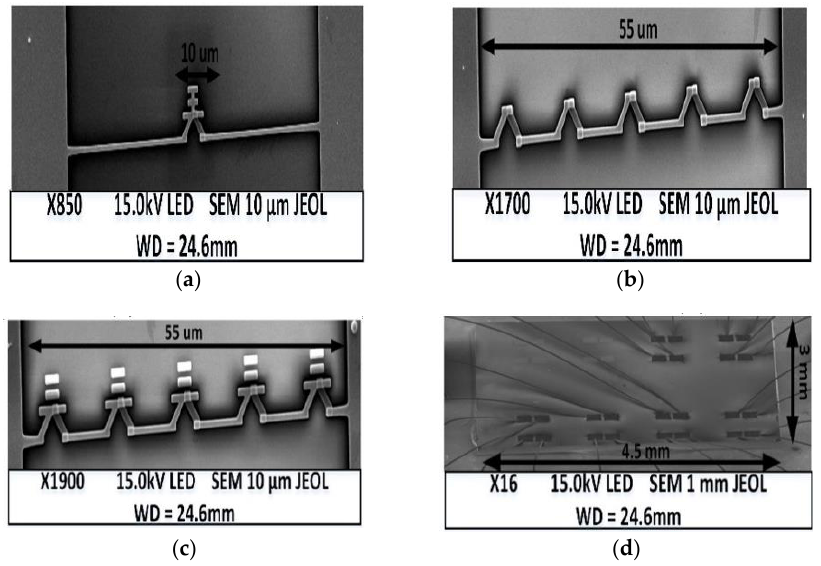
Figure 11. Realized structures for 1550-nm laser excitation: ( a ) Quasi-Yagi–Uda; ( b ) array of the nano-thermoelectric junction; ( c ) array of traditional Yagi–Uda; ( d ) zoomed out image of the nanoantenna chip showing the wire-bonding.